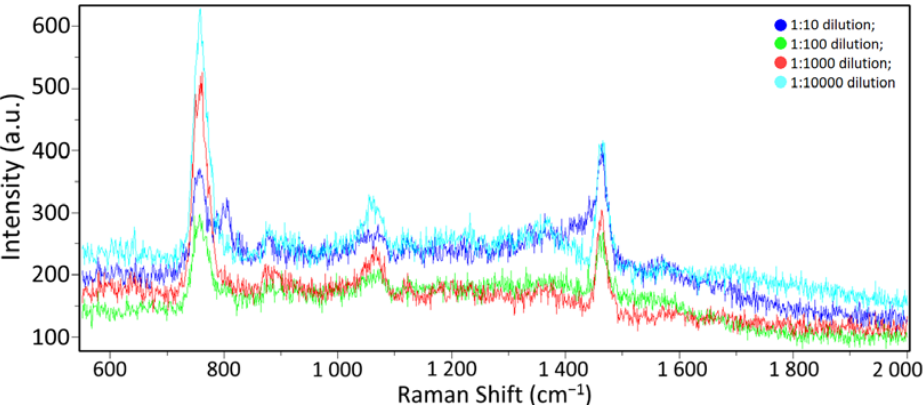
Figure 6. Influenza A virus in different dilutions: dark blue line—1:10 dilution; green line—1:100 dilution; red line—1:1000 dilution; light blue line—1:10,000 dilution.